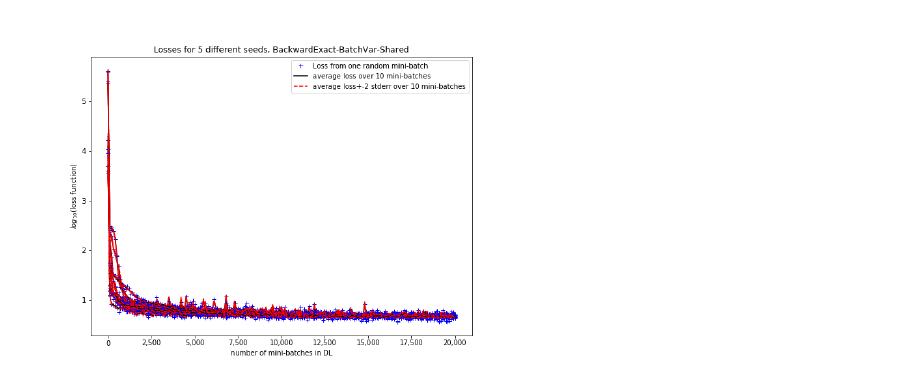
Figure 9. Loss function over 20,000 mini-batches for the short and long straddle for batch-variance method with exact backward step with a single DNN for π for five independent realizations. Behavior is very similar for other